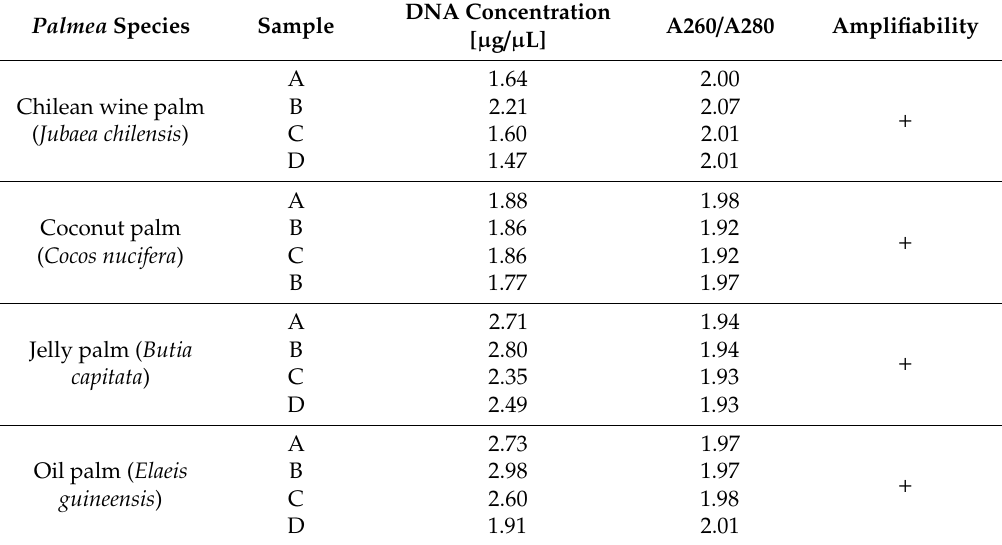
Table 2. Properties of the DNA extracted from the leaves of coconut palm ( Cocos nucifera ), Chilean wine palm ( Jubaea chilensis ), oil palm ( Elaeis guineensis ), and jelly palm ( Butia capitata ). DNA Concentration Palmea Species Sample [ µ g / µ L]